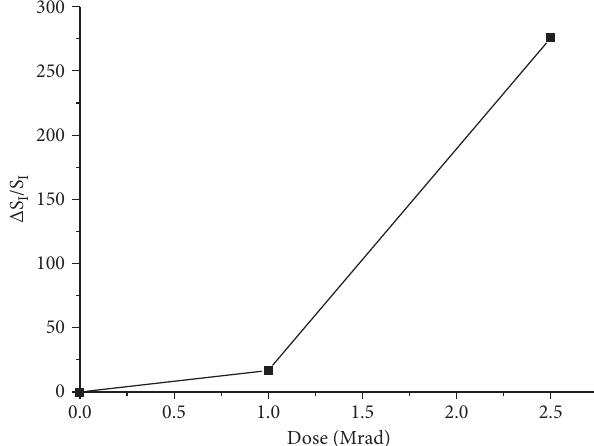
Figure 4: Variation of current noise spectral density with total dose ( f � 20 Hz).